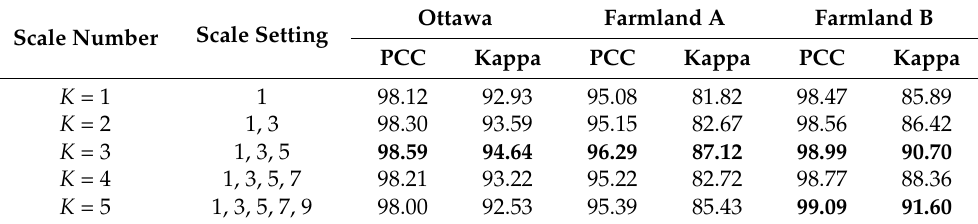
Table 5. Effect of the scale